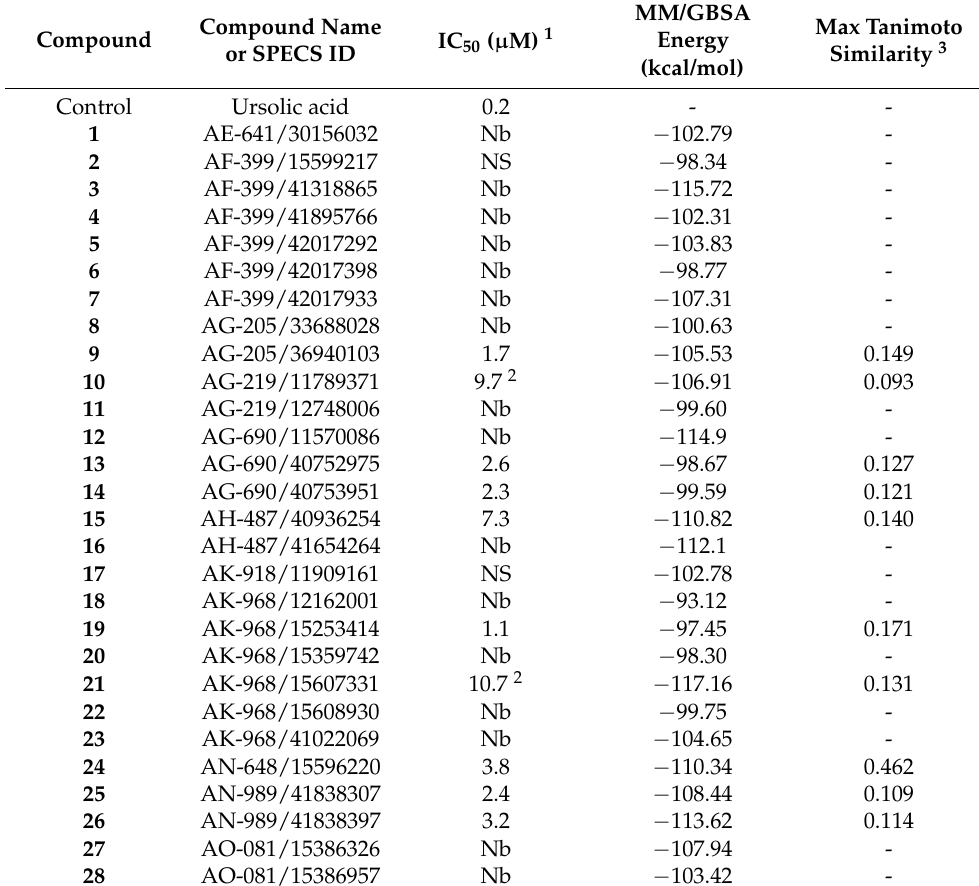
Table 1. The experimental results, binding energy predictions, and similarities with known ROR γ t inverse agonists or antagonists for virtual screening hit compounds.